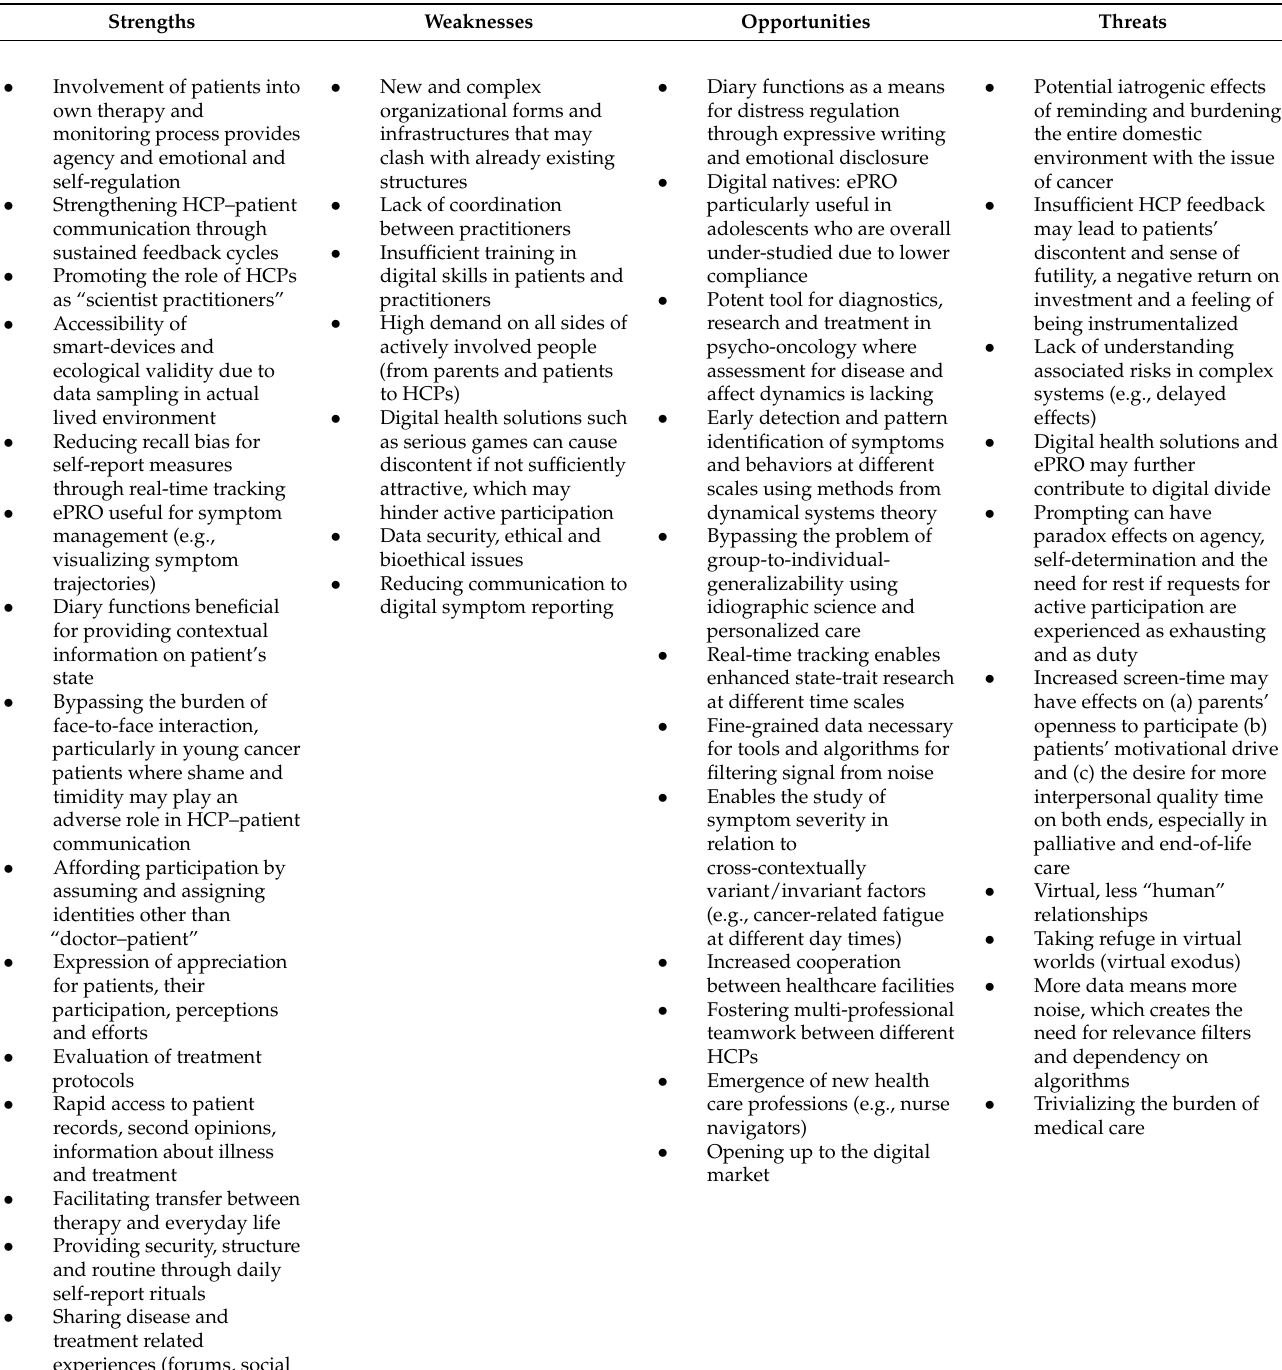
Table 2. SWOT analysis of ePRO use in CAYA psycho-oncology. Abbreviations: HCP = health care professionals, ePRO = electronic patient-reported outcomes. Adapted from